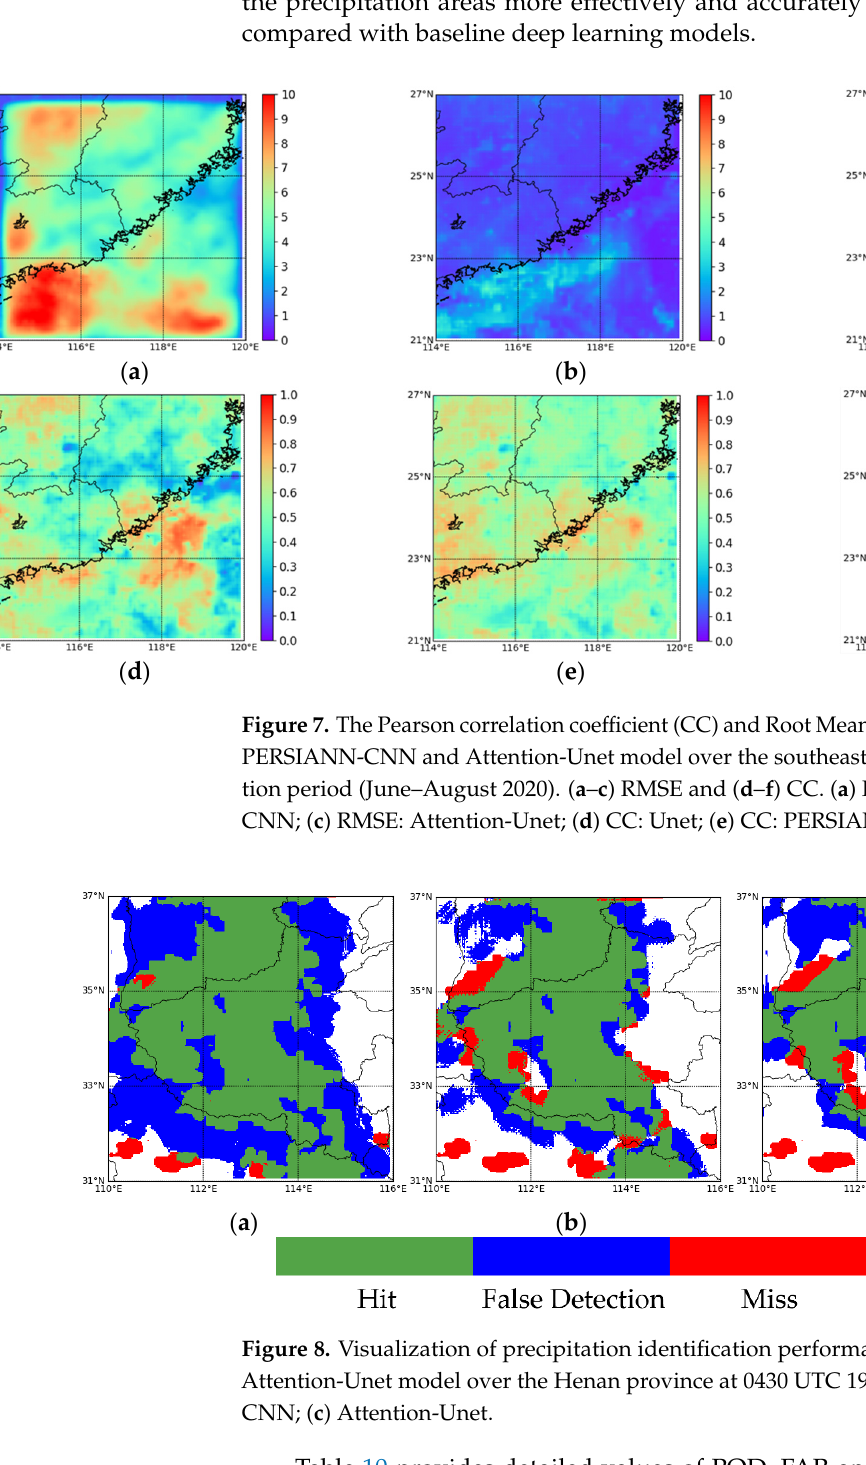
Table 10. Summary of precipitation identification performances over extreme precipitation events.